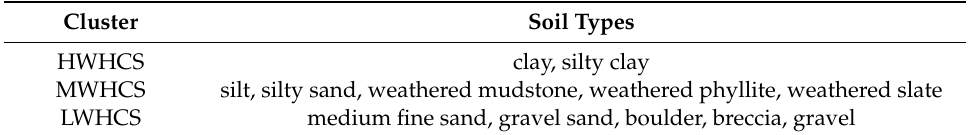
Table 2. Classification of testing